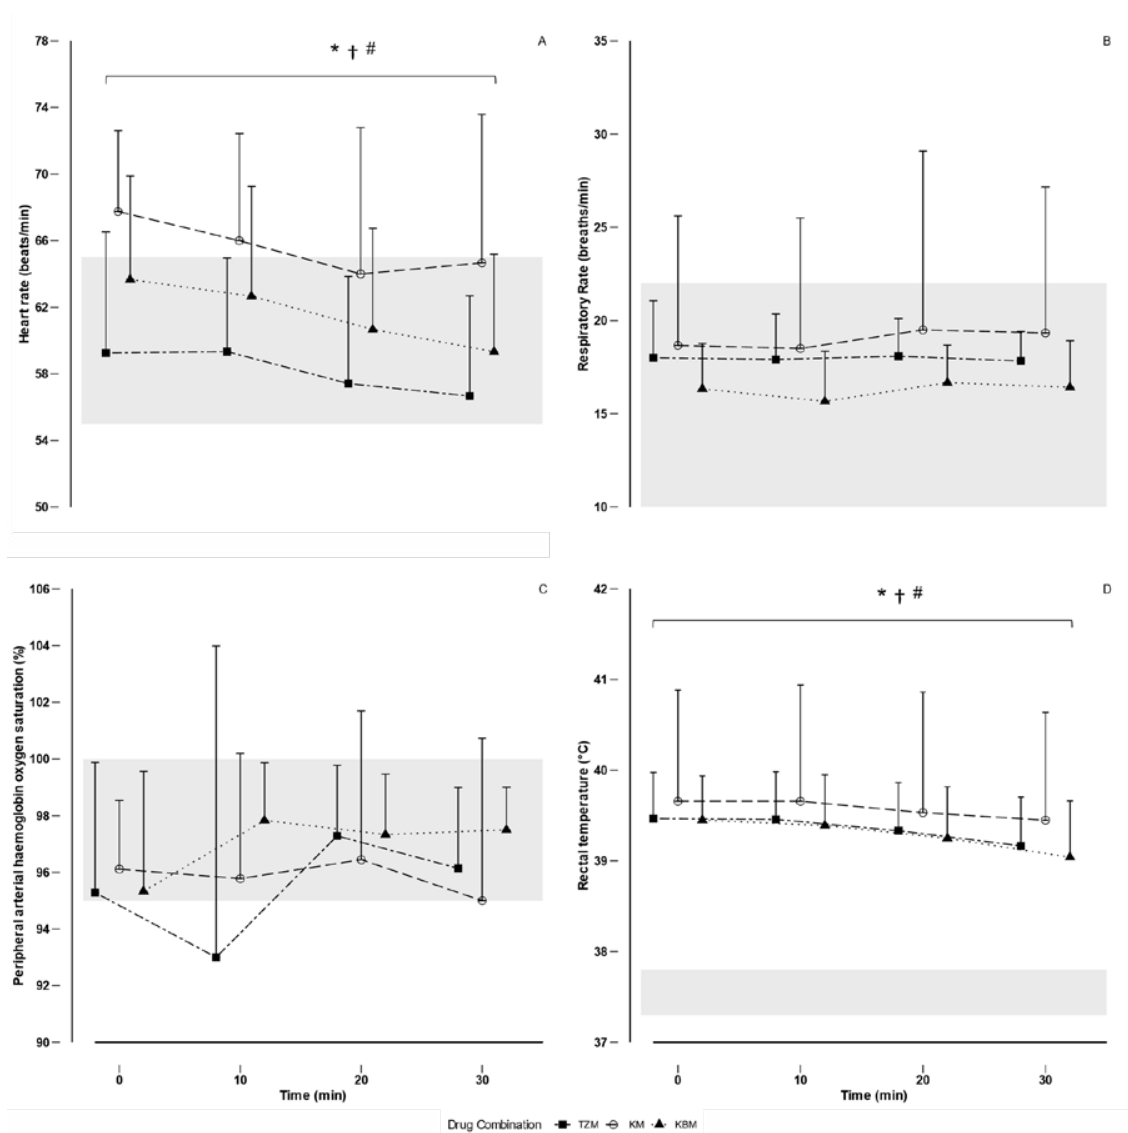
Figure 2: Mean and SD of A) heart rate, B) respiratory rate, C) peripheral arterial haemoglobin saturation with oxygen (SpO in free-ranging African lions ( Panthera leo ) immobilised with tiletamine-zolazepam-medetomidine (TZM), ketamine-medetomidine (KM) or ketamine- butorphanol-medetomidine (KBM). Note: Shaded areas represent: A) heart rate in awake, unrestrained lions (Al-Naji et al. 2019); B) respiratory rate in awake, unrestrained lions (Al-Naji et al. 2019); C) peripheral arterial haemoglobin saturation with oxygen in awake, unrestrained domestic cats